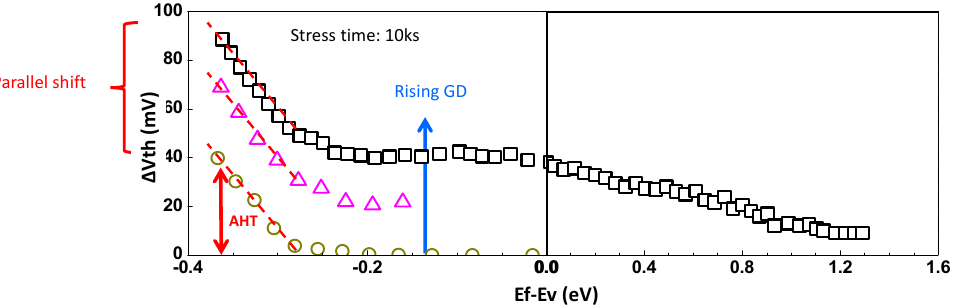
Figure 11. The as-grown defects “A” are located below silicon Ev. The generated defects are above Ev. The stress did not change the as-grown defects, as shown by the parallel upward shift of the dashed lines [35,36].